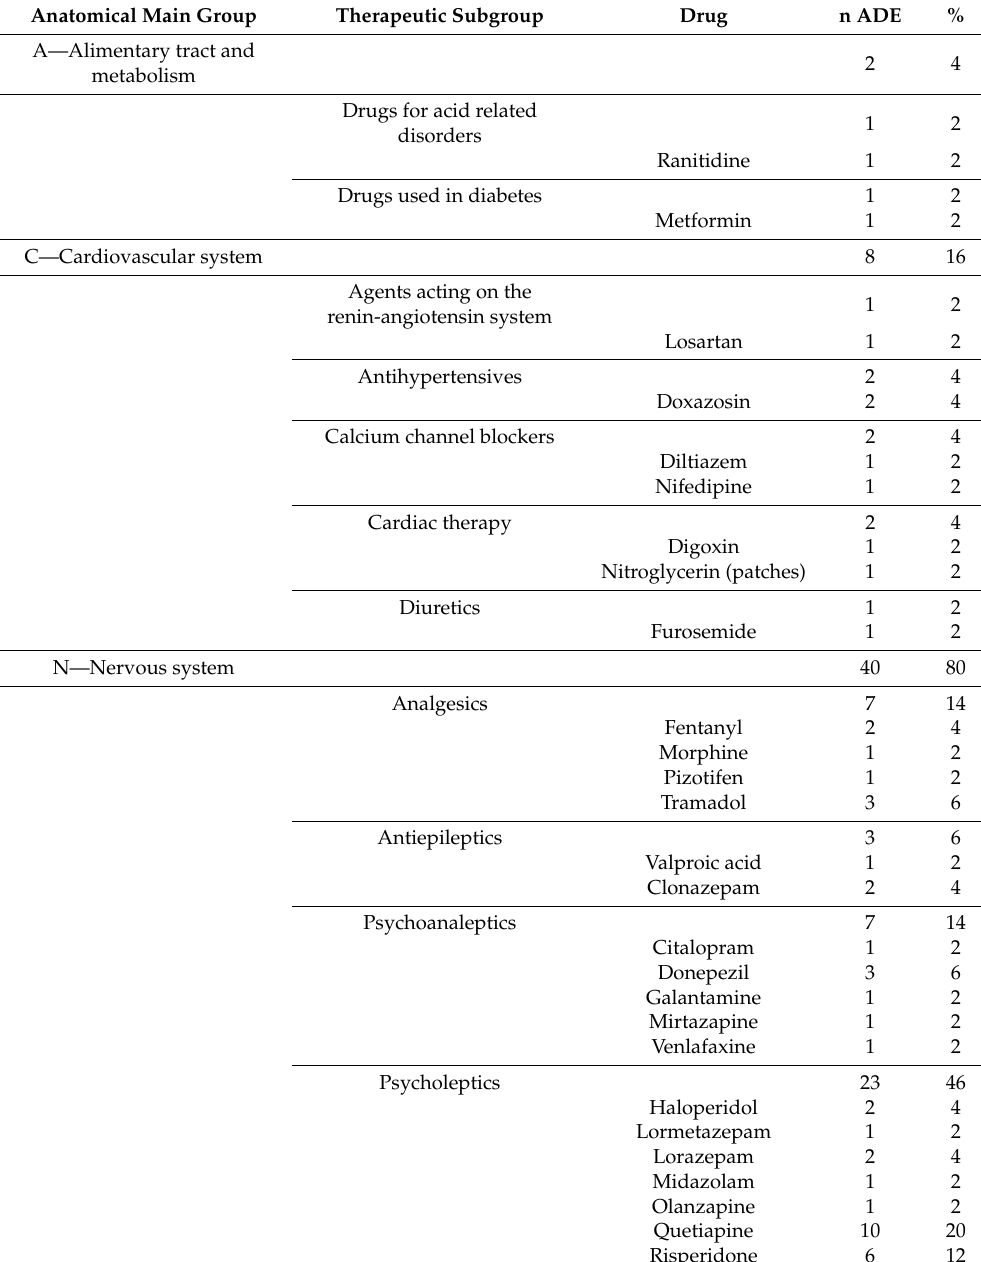
Table 2. Distribution of adverse drug effects (ADEs) by the main anatomical group, therapeutic group, and